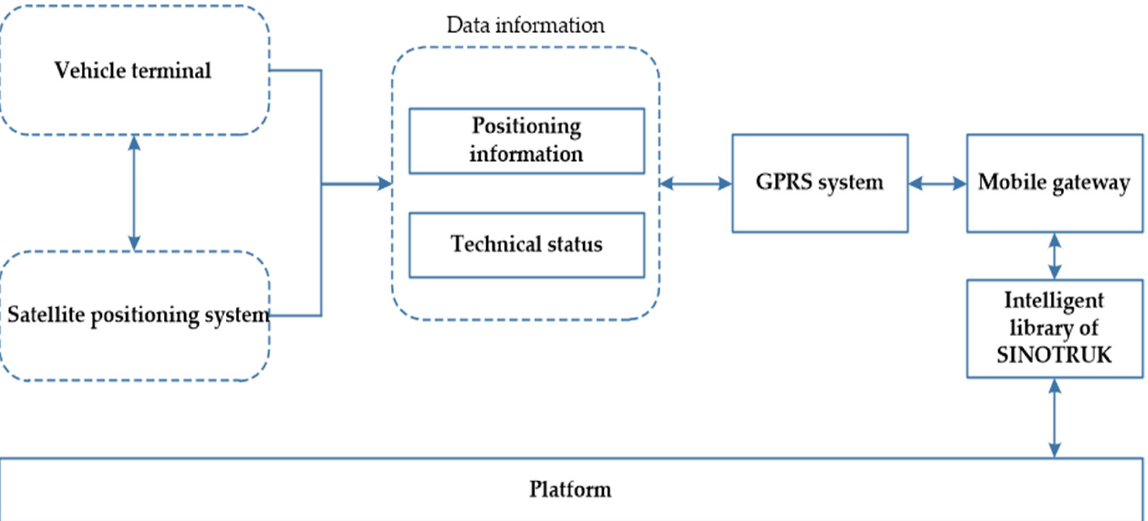
Figure 3. Schematic diagram of SINOTRUK Intelligent Platform.